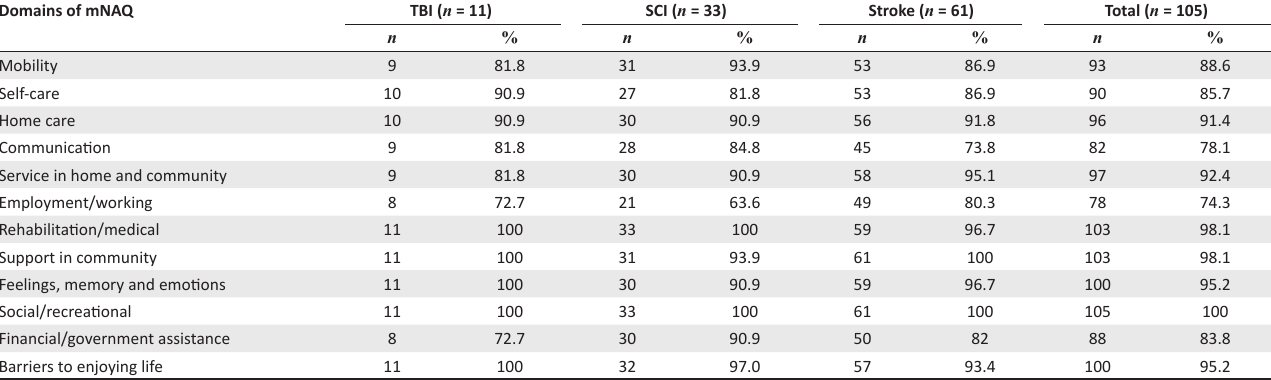
TABLE 2: Frequency of expressed needs across neurological conditions as scored by modified Needs Assessment Questionnaire ( n = 105). Domains of